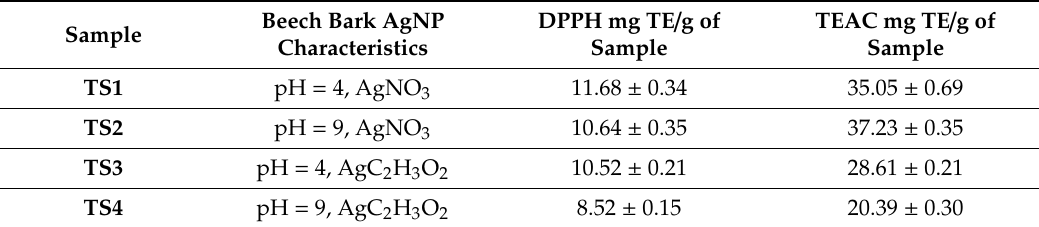
Table 1. Antioxidant activity of